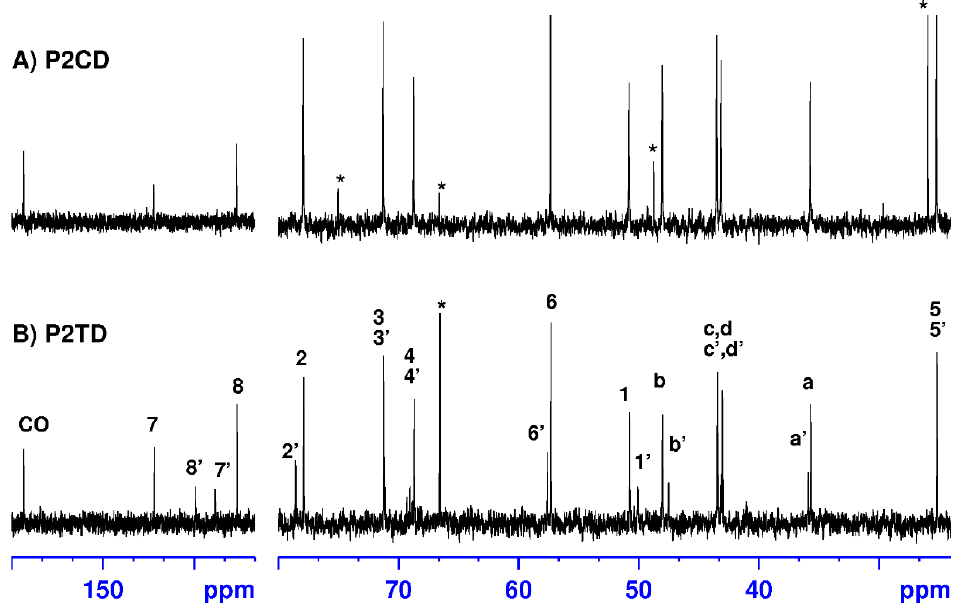
Figure 5. 13 C NMR spectra of the deprotected polymers P2CD and P2TD recorded in deuterium oxide. The P2TD spectrum shows duplication of some signals due to the presence of two regioisomeric triazole rings in the polymer chain. Signals marked with an asterisk correspond to solvents.